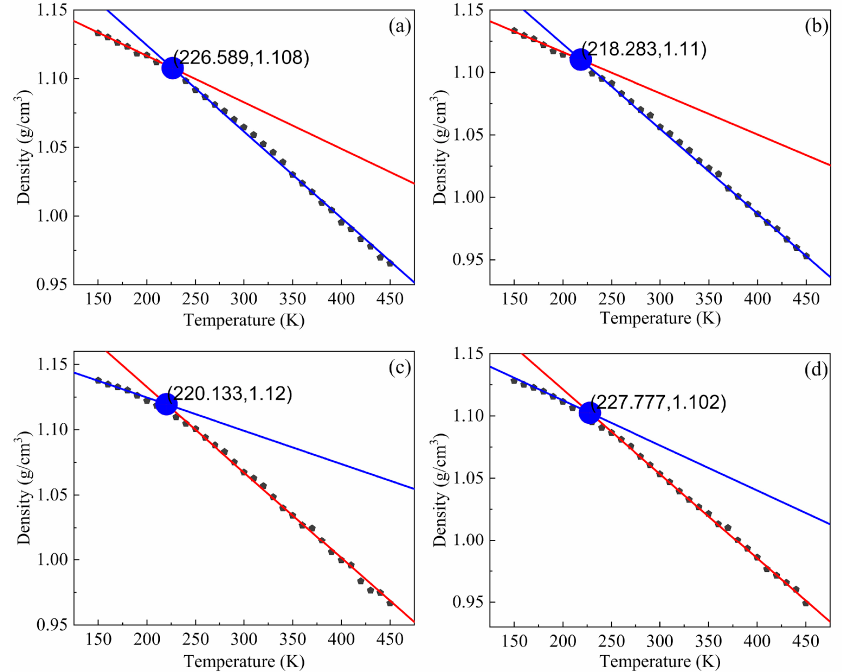
Figure 5. The glass transition temperatures of four interpenetrating polymer structure binder models. ( a ) S-N, ( b ) S-H, ( c ) S-T and ( d ) S-I.